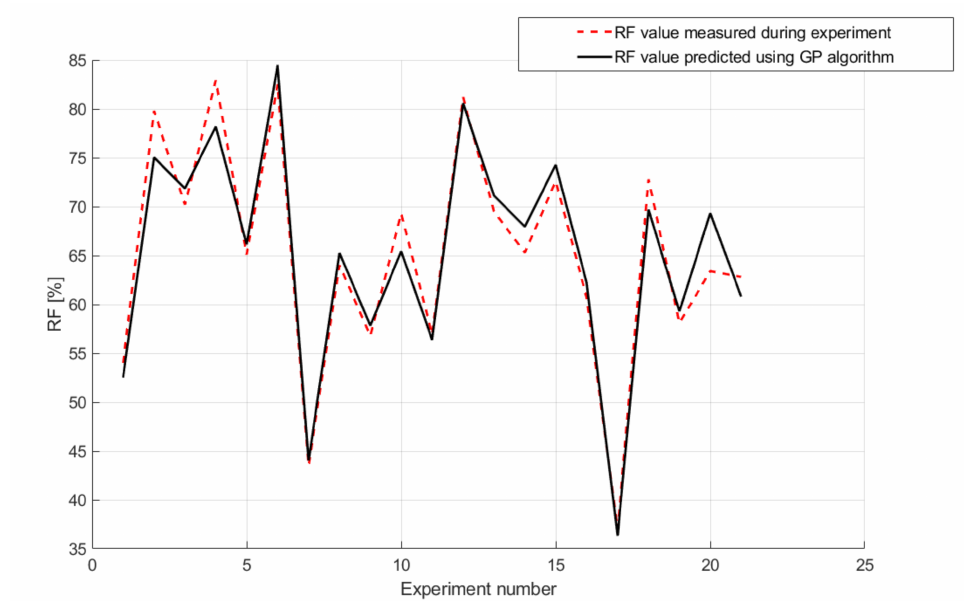
Figure 15. RF model fitting to the experimental results. The minimum value of the absolute error expressed as the modulus of the difference between calculated and experimentally derived RF is about 0.5 p.p., the maximum value is about 6 p.p. when the average is about 2 p.p. (Figure 16). A relative error, expressed as the modulus of the absolute error divided by the magni- tude of the experimentally derived RF, was also used for the fitting evaluation. The mean relative error was about 3% (Figure 17).